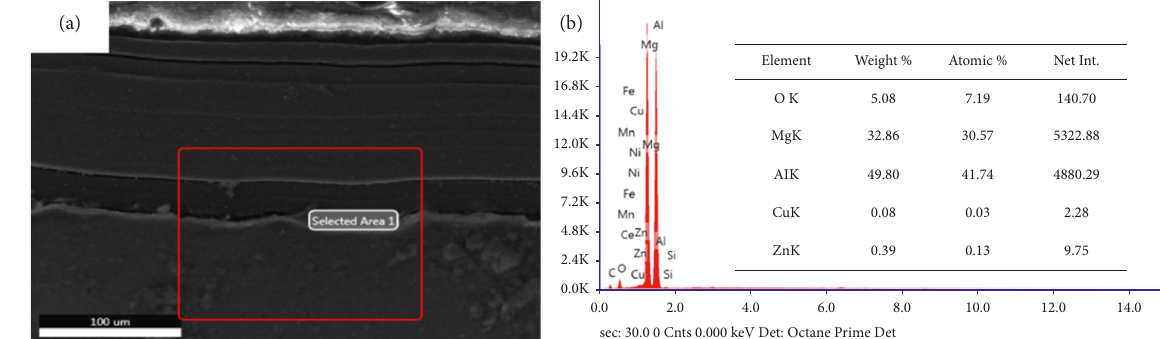
Figure 7: SEM images of epoxy CED samples of AZ91D+0.1wt.% Ce+0.1wt.% Li Mg